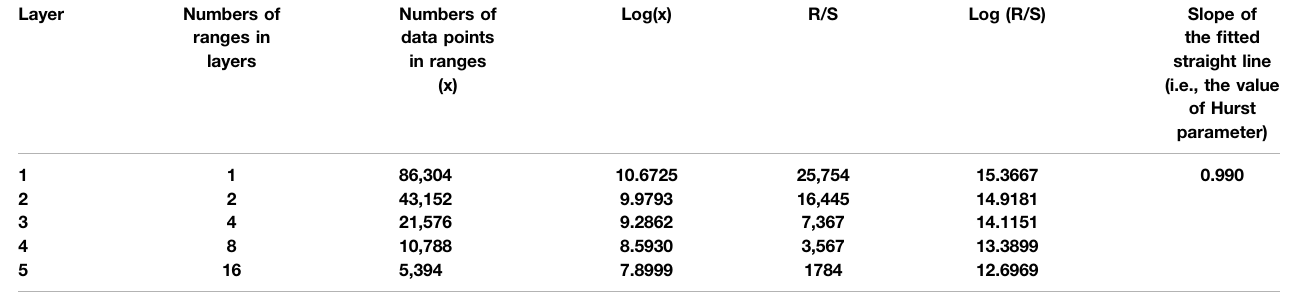
Slope of the fi tted